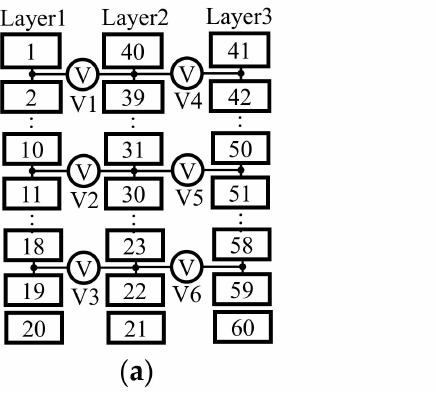
Figure 18. Testing points of the interlayer voltage drop in different winding structures: ( a ) C-type; ( b ) Z-type.